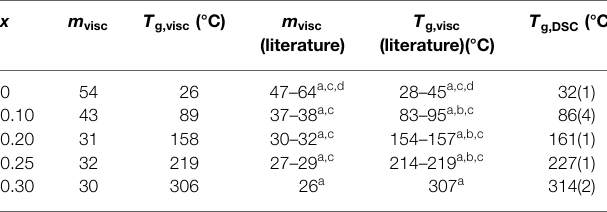
The results obtained by fitting viscosity data to the MYEGA model with log 10 [ (cid:17) 1 (Pas)] = − 2.93 ( Figure 11 ) are compared to values of m visc and T g,visc taken from the literature. Also listed are the values of the glass transition temperature T g,DSC taken from the onset of the glass transition in the total heat flow measured in the TMDSC experiments of the present work ( Figure 4 ). a Gueguen et al. (2011). b Nemilov (1964). c Senapati and Varshneya (1996). d Svoboda and Málek (2015).